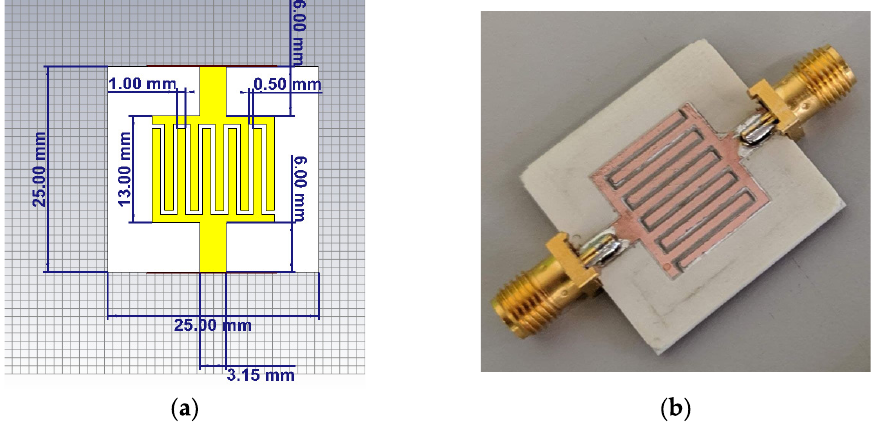
Figure 1. Microwave transducer prototype: ( a ) Sketch of the IDC with dimensions; ( b ) photo of the fabricated